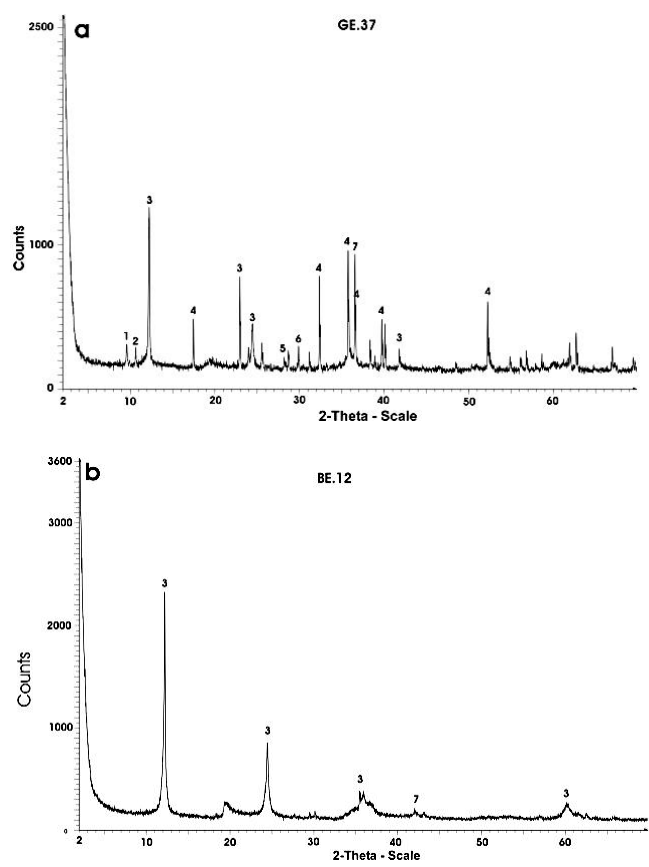
Figure 3. Representative X-ray diffraction patterns of the studied ultramafic rock samples: ( a ) dunite and ( b ) serpentinized harzburgite. Sample numbers are indicated as insets (1: talc, 2: anthophyllite, 3: lizardite, 4: olivine, 5: orthopyroxene, 6: magnetite, 7: spinel).